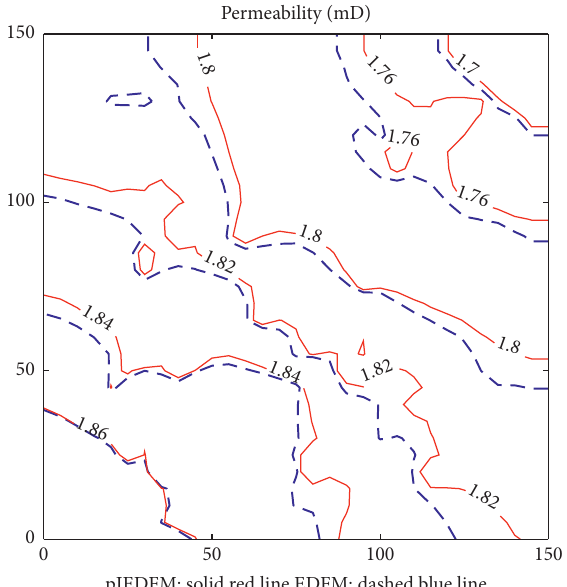
pIEDFM: solid red line EDFM: dashed blue line Figure 31: Contour map of permeability distribution after 20000days of